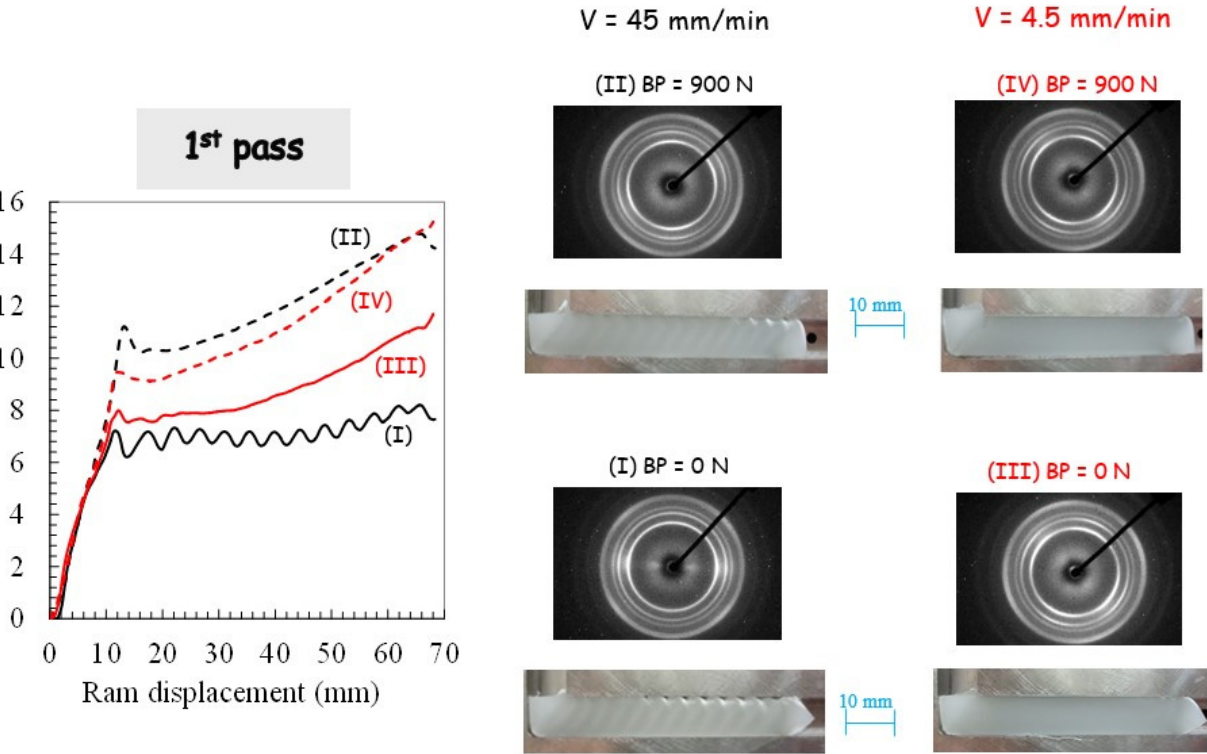
Figure 3. Results of the first pass extrusion in terms of load-displacement curve, deformation behavior and X-ray diffraction for different processing parameters: ( I ) Ram velocity of 45 mm/min and BP of 0 N, ( II ) Ram velocity of 45 mm/min and BP of 900 N, ( III ) Ram velocity of 4.5 mm/min and BP of 0 N, ( IV ) Ram velocity of 4.5 mm/min and BP of 900 N.